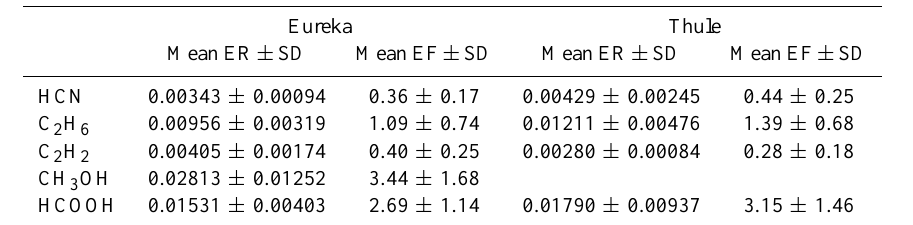
Table 7. Means and 1-sigma standard deviations of equivalent emission ratios and emission factors (using EFco for the extratropical forest) calculated from FTIR measurements performed at Eureka and Thule for HCN, C 2 H 6 , C 2 H 2 , CH 3 OH, and HCOOH. Standard deviations are smaller than in Tables 5 and 6 because filters (using threshold values on the linear correlation coefficient ( r > 0 . 6) and the number of points ( N ≥